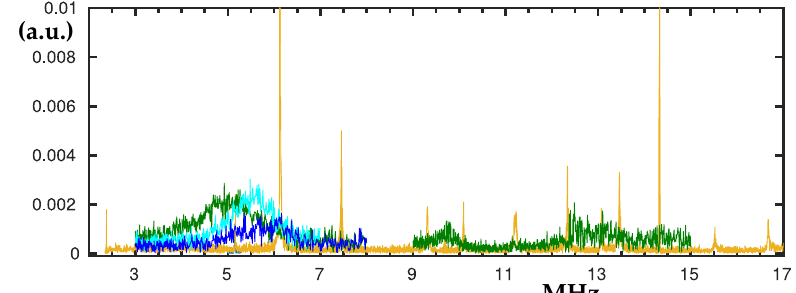
Figure A8. In the background (yellow) is the experimental frequency response spectrum as in Figure 2 where the frequency range was swiped-up in vacuum. The frequency response in air is added on the top, where the blue, cyan and green curves denote V DC = 20 V, V DC = 30 V and V DC = 40 V, respectively. V pp = 16 V between 3 MHz and 8 MHz and V pp = 18 V between 9 MHz and 15 MHz. Resonant peaks were not detected between 8 MHz and 9